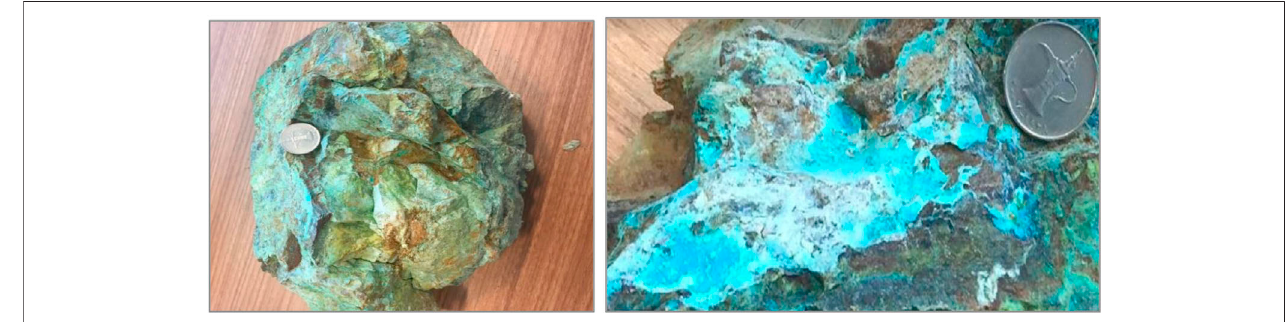
FIGURE 7 | Photographs of malachite and azurite.